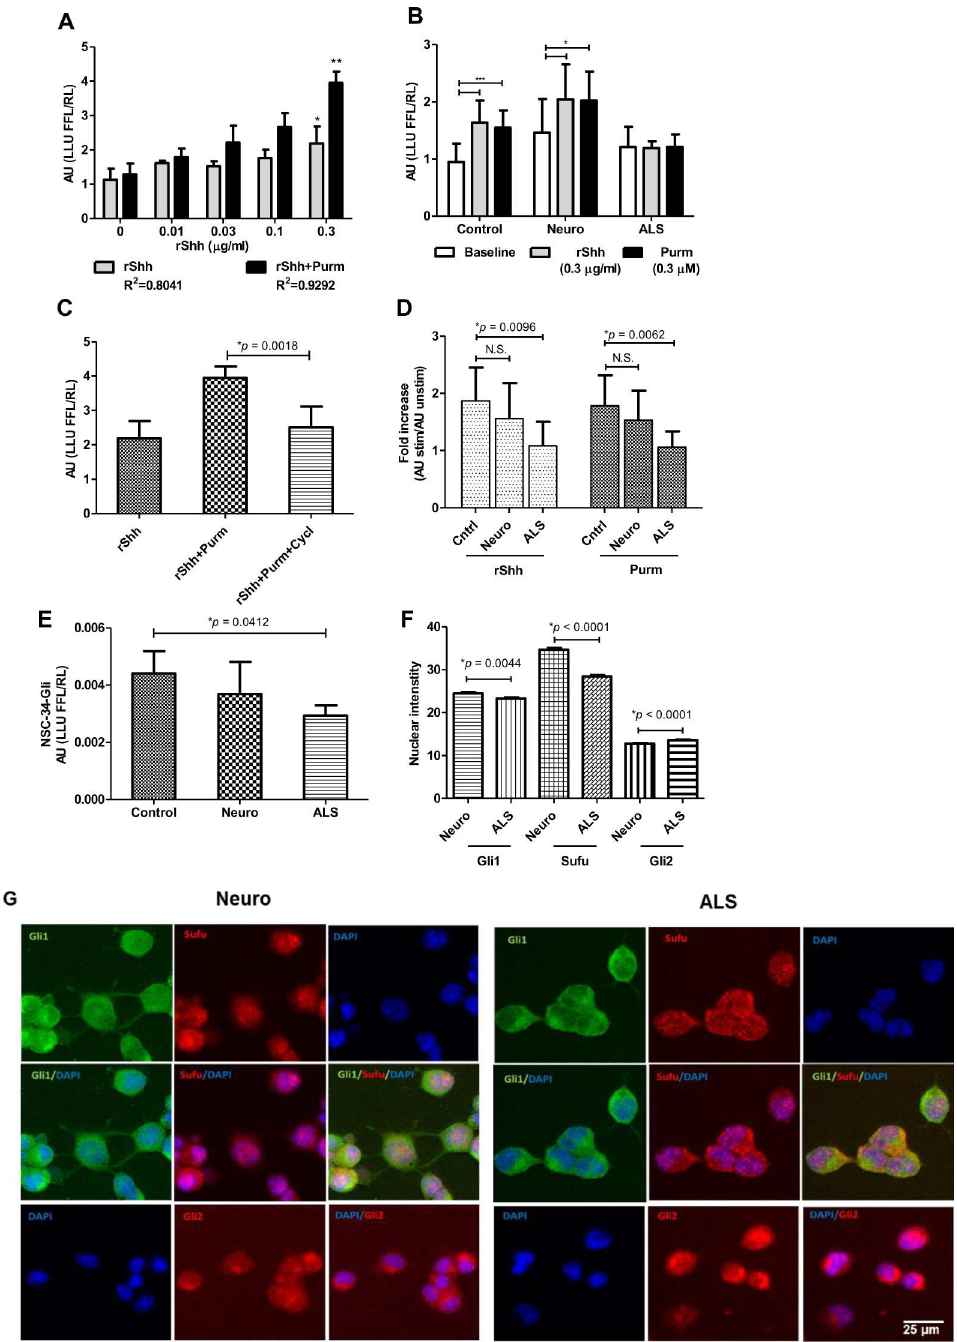
Fig 2. ALS CSF inhibits Shh biological activity in vitro . (A) StandardcurveswithR 2 demonstrate a dose- dependentresponseof Shh-LTII cellsto humanrecombinantShh (rShh)andpurmorphamine(Purm)(0.3 μ M). Shh-LTII cellswereculturedwithrShhand PurmanddevelopedwithPromegaDual-GloLuciferaseAssay System, assayingfor firefly (FFL) and Renilla(RL) luciferase-drivenluminescencemeasuredas luminescence lightunit(LLU).Dataareexpressedas mean ± SD andshownas arbitraryunits (AU)whereFFL was normalizedto RL (LLUFFL/RL). * and ** indicatesignificantdifferencesfrom mediaalonefor rShhandPurm, correspondingly, basedon a onewayANOVA analysiswith Tukeypost- hoc test ( p < 0.05).(B) The inhibitory effect of ALSCSF on Shhbiologicalactivitymeasuredin Shh-LTIIcells is shown.FullyconfluentShh-LTII cellswereincubatedeither withCSF alone,half-dilutedwithreduced-serummediumas a baseline(whitebar), or in the presence of rShh (0.3 μ g/ml)(greybar)or Purm (0.3 μ M)(blackbar) andassayedwithPromega.Data areexpressedas mean ± SD